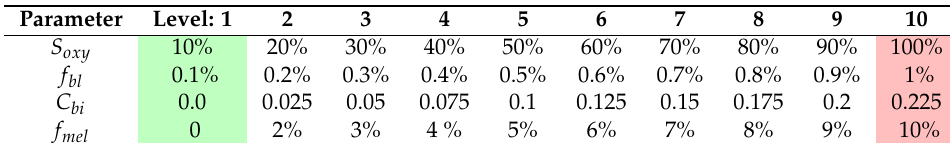
Table 2. Parameter range for MCML (Monte Carlo modelling of light transport in multi-layered tissues) skin simulation [39,61] resulting in 10,000 different parameter combinations. S oxy is the saturation of oxygenation, f bl and f mel the volume fraction of blood and bilirubin, and C bi describes the bilirubin concentration. Green and red Shadings indicate extreme values of simulation